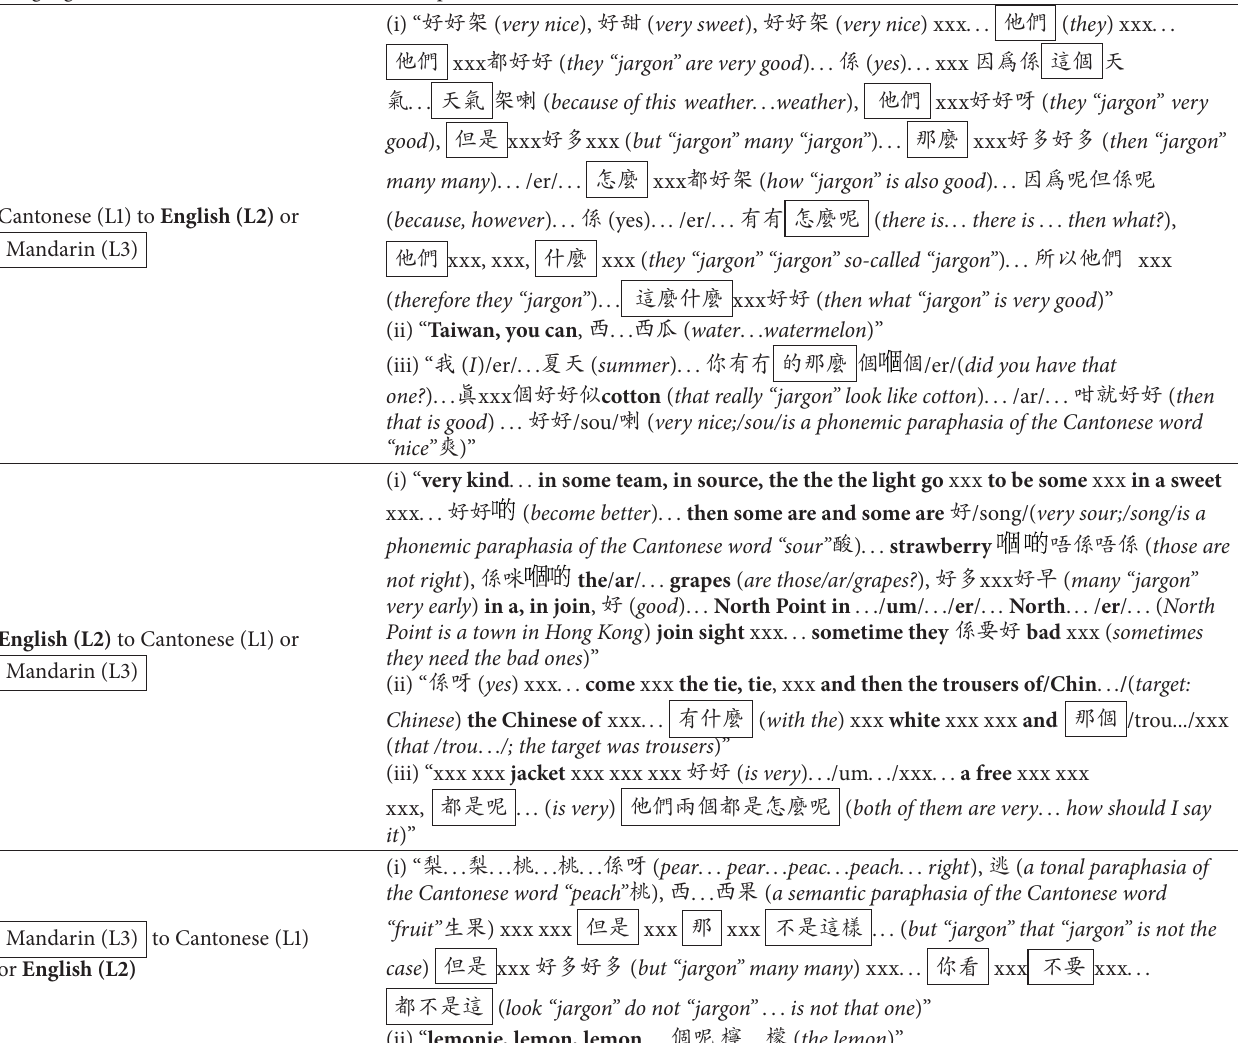
Table 3: Samples of Dr. T’s code switching at the discourse